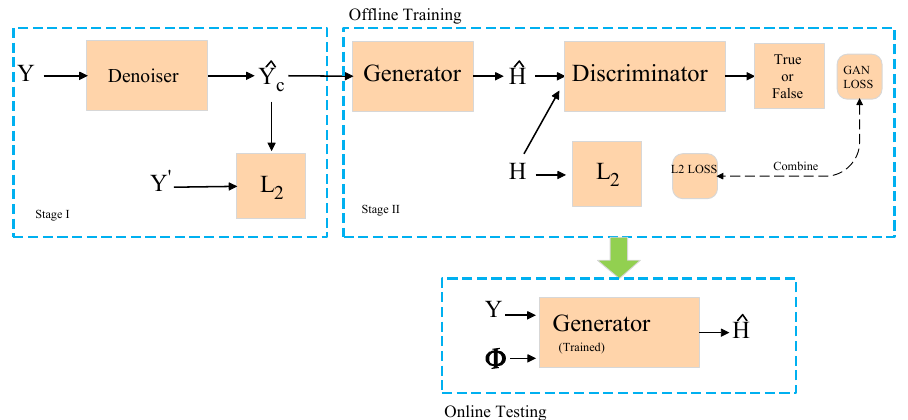
Figure 3. Diagram of N2N-cGAN channel